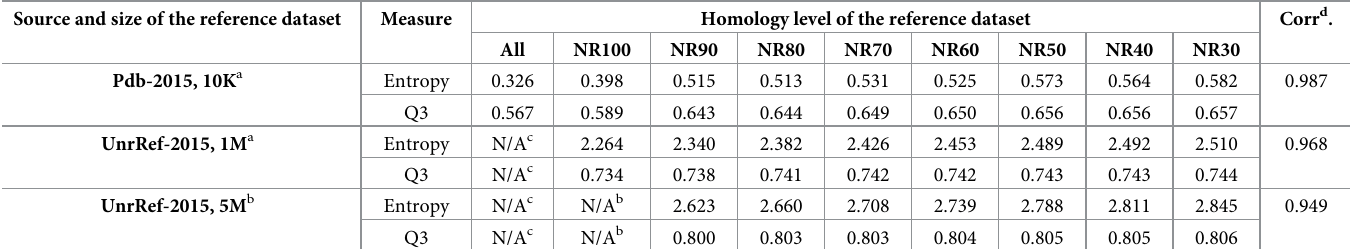
a Results of the TS115 independent test of Fig 5 (10,000 proteins) and Fig 6 (1 million proteins). b Results of the TS115 independent test of the Fig 6 of [50] (5 million proteins). The NR100 identity level was not tested. c Not available because the UniRef database only provided non-redundant sets. d Pearson’s correlation